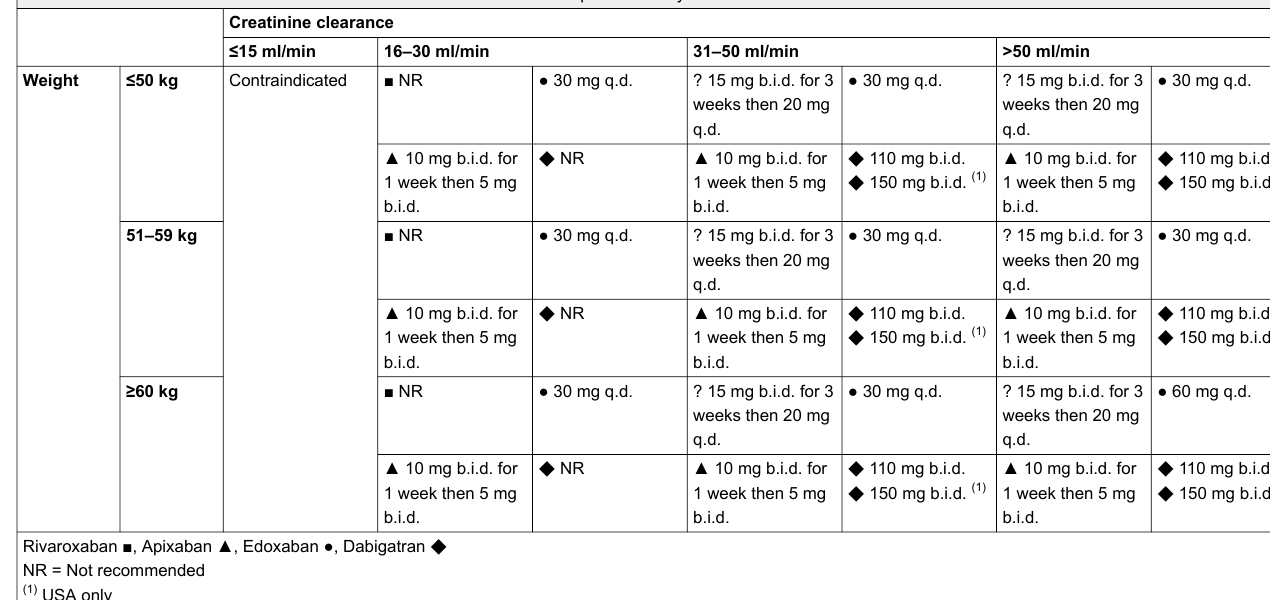
Table 4: Dose recommendation for venous thromboembolism treatment in patients ≥80 years